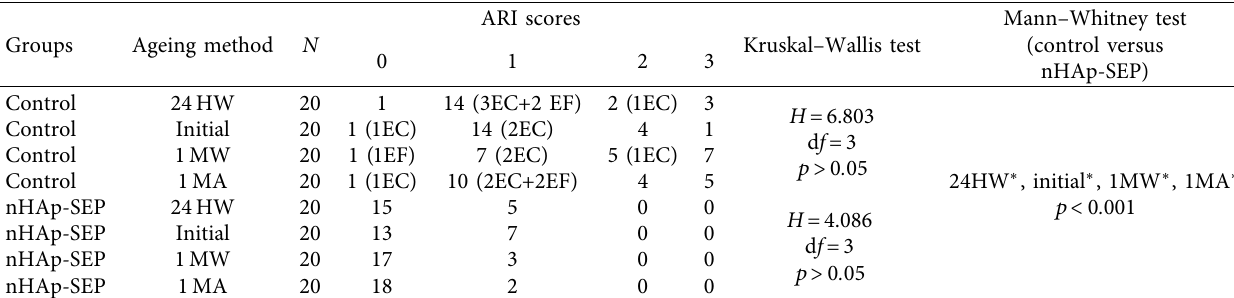
Table 5: Descriptive and inferential statistics of adhesive remnant index (ARI) scores of bracket debonding at four ageing protocols: 24h